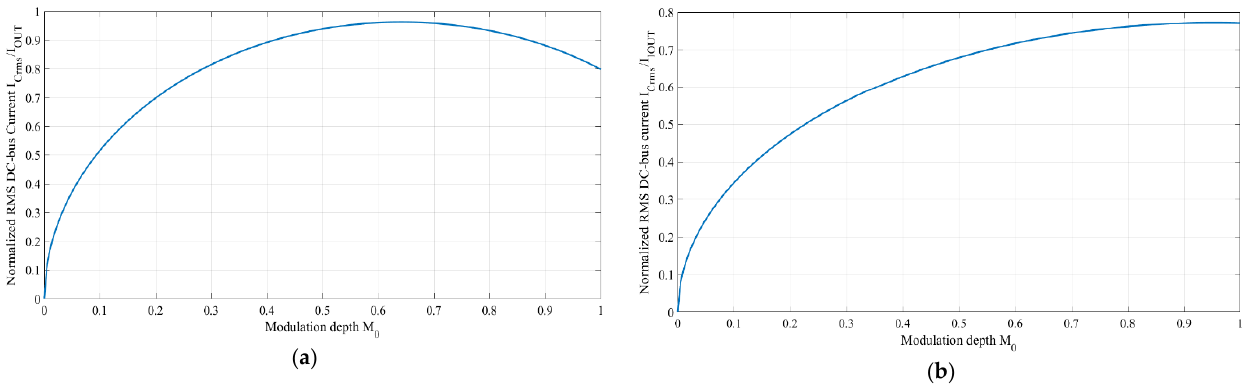
Figure 7. Normalized RMS DC-bus current as a function of the modulation depth: ( a ) cos φ = 1, ( b ) cos φ = 0.